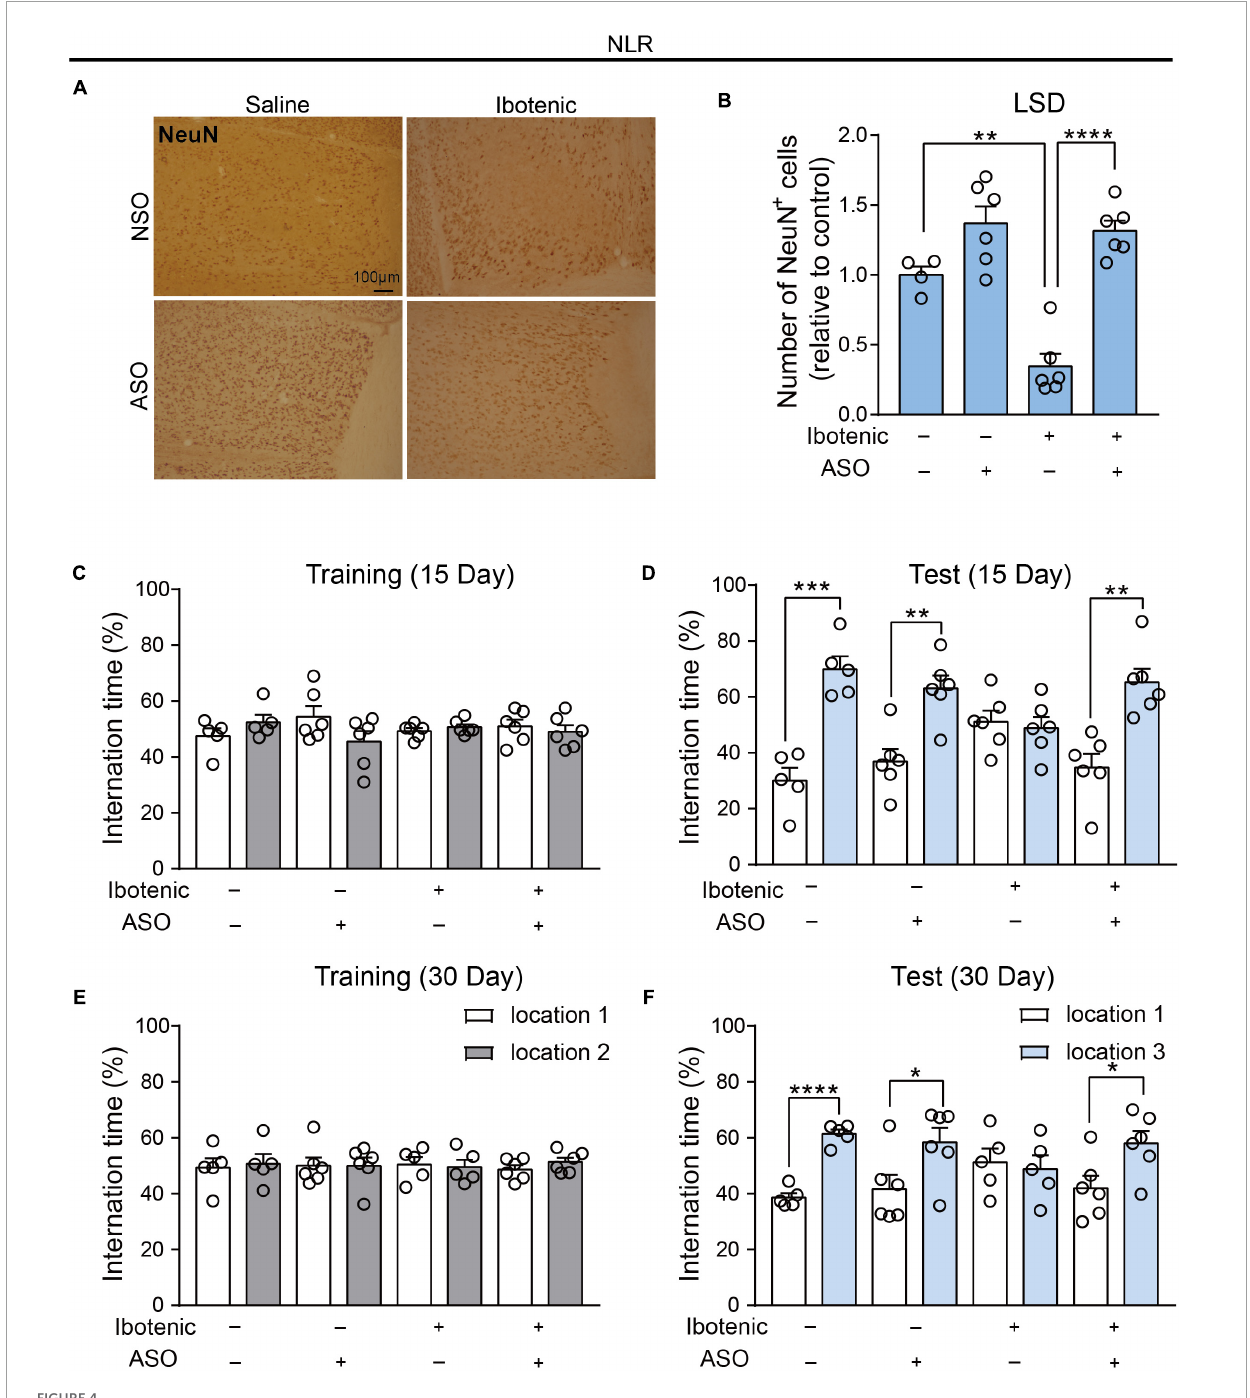
FIGURE4 Antisense oligonucleotide injection rescued the spatial recognition memory in the lesioned mice by functional neuronal regeneration. (A) Representative images of NeuN-positive cells in the LSD. Scale bar, 100 µ m. (B) The number of NeuN positive cells in the LSD (saline/NSO: n = 4; saline/ASO: n = 6; Ibotenic/NSO: n = 6; Ibotenic/ASO: n = 6). Two-way ANOVA: Ibotenic, F ( 1 , 18 ) = 13.38, p = 0.0018; ASO, F ( 1 , 18 ) = 47.77, p < 0.0001; interaction, F ( 1 , 18 ) = 9.635, p = 0.0061; ** p < 0.01, **** p < 0.0001 with Bonferroni’s post-hoc test. (C) The interaction time (%) of NLR during the training phase 15 days after ASO injection (saline/NSO: n = 5; saline/ASO: n = 6; Ibotenic/NSO: n = 6; Ibotenic/ASO: n = 6). Unpaired t -test: saline/NSO: t ( 8 ) = 1.272, p = 0.2390; saline/ASO: t ( 10 ) = 1.693, p = 0.1213; Ibotenic/NSO: t ( 10 ) = 0.9252, p = 0.3766; Ibotenic/ASO: t ( 10 ) = 0.5864, p = 0.5706. (D) The interaction time (%) of NLR during the test phase 15 days after ASO injection (saline/NSO: n = 5; saline/ASO: n = 6; Ibotenic/NSO: n = 6; Ibotenic/ASO: n = 6). Unpaired t -test: saline/NSO: t ( 8 ) = 6.123, *** p = 0.0003; saline/ASO: t ( 10 ) = 4.119, ** p = 0.0021; Ibotenic/NSO: t ( 10 ) = 0.3960, p = 0.7004; Ibotenic/ASO: t ( 10 ) = 4.418, ** p = 0.0013. (E) The interaction time (%) of NLR during the training phase 30 days after ASO injection (saline/NSO: n = 5; saline/ASO: n = 6; Ibotenic/NSO: n = 5; Ibotenic/ASO: n = 6). Unpaired t -test: saline/NSO: t ( 8 ) = 0.3053, p = 0.7680; saline/ASO: t ( 10 ) = 0.005915, p = 0.9954; Ibotenic/NSO: t ( 8 ) = 0.2654, p = 0.7974; Ibotenic/ASO: t ( 10 ) = 1.225, p = 0.2487. (F) The interaction time (%) of NLR during the test phase 30 days after ASO injection (saline/NSO: n = 5; saline/ASO: n = 6; Ibotenic/NSO: n = 5; Ibotenic/ASO: n = 6). Unpaired t -test: saline/NSO: t ( 8 ) = 10.08, **** p < 0.0001; saline/ASO: t ( 10 ) = 2.313, * p = 0.0433; Ibotenic/NSO: t ( 8 ) = 0.3423, p = 0.7409; Ibotenic/ASO: t ( 10 ) = 2.58, * p =